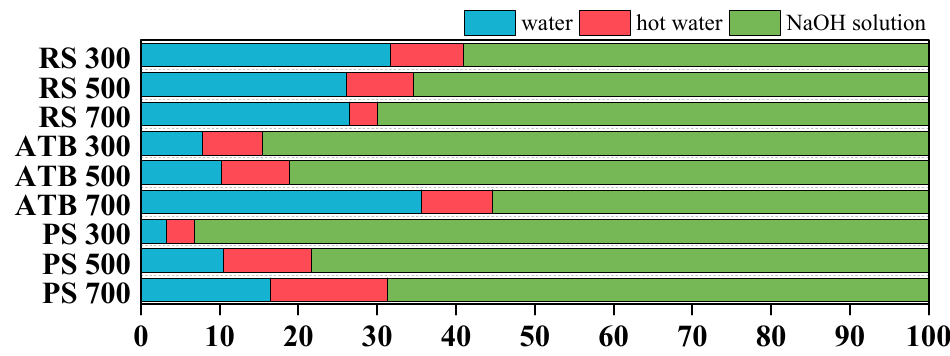
Figure 1. The distribution of DOC concentration in water, hot water and NaOH solution. Table 2. DOC concentrations (mg·g − 1 ) of RS, ATB and PS biochars released in the different extraction solutions ( n = 3).